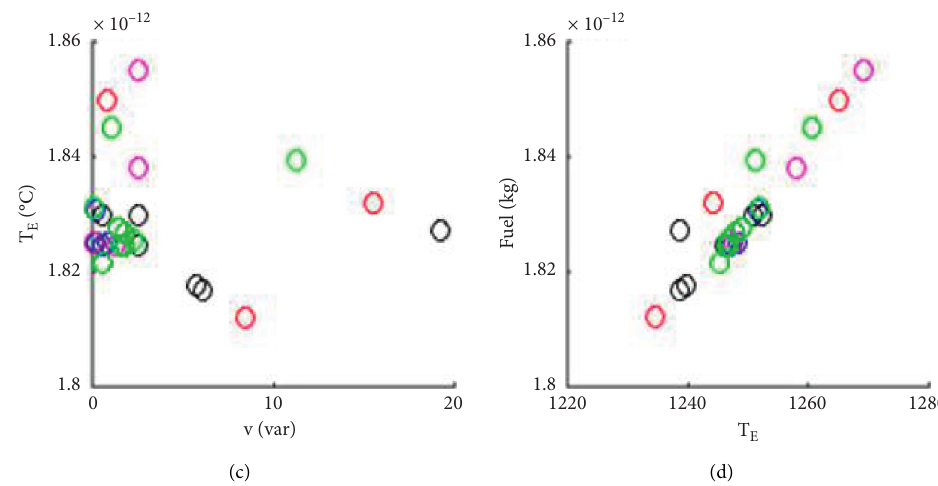
Figure 6: Three optimization objectives and analysis